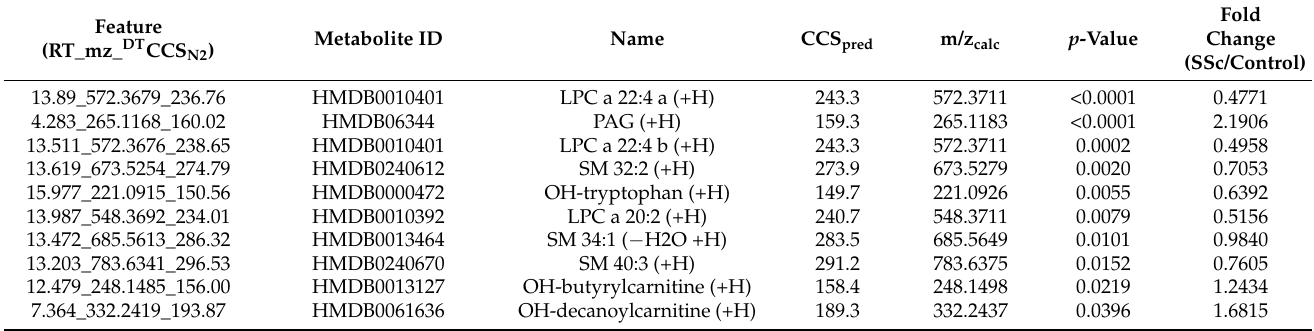
Table 2. Dysregulated metabolites were identified by the untargeted metabolomics approach. A feature consists of retention time (RT), measured mass to charge ratio (m/z), and the measured cross collision section ( DT CCS N2 ). LPC = lysophosphatidylcholine, PAG = phenylacetylglutamine, Cer = ceramide, SM = sphingomyeline, CCS pred was retrieved from AllCCS [22] predictor. p -value was determined by a two-tailed Student’s t-test. Fold change was calculated from the ratio of SSc to control